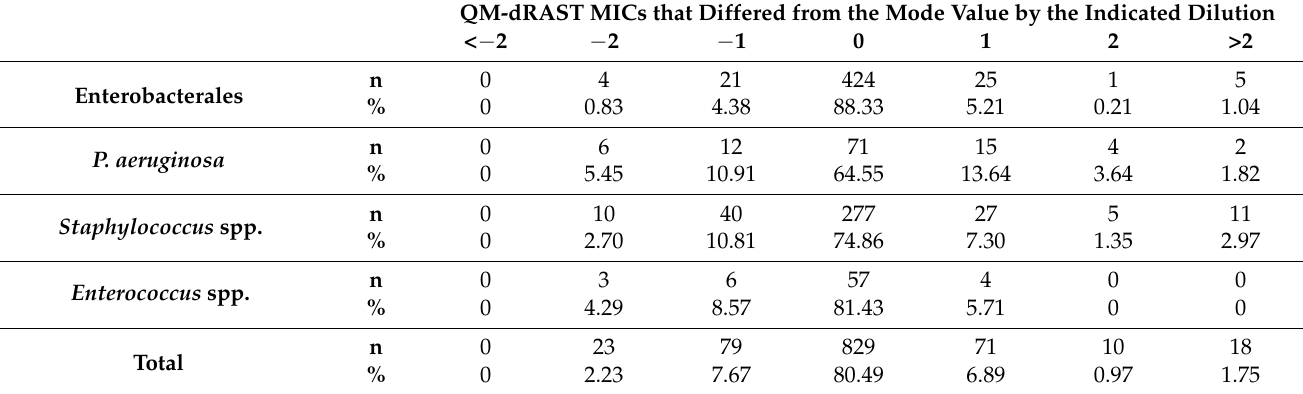
Table 4. Reproducibility results obtained with the